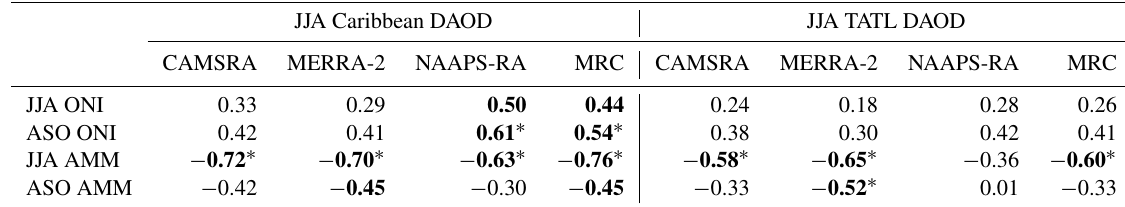
Table 5. Correlations of MRC JJA Caribbean DAOD or JJA tropical North Atlantic (TATL) DAOD with the JJA or ASO Oceanic Niño Index (ONI) and the AMM. Correlations that are statistically significant at the 90% level are highlighted in bold. Correlations that are statistically significant at the 95% level are marked with an asterisks. JJA Caribbean